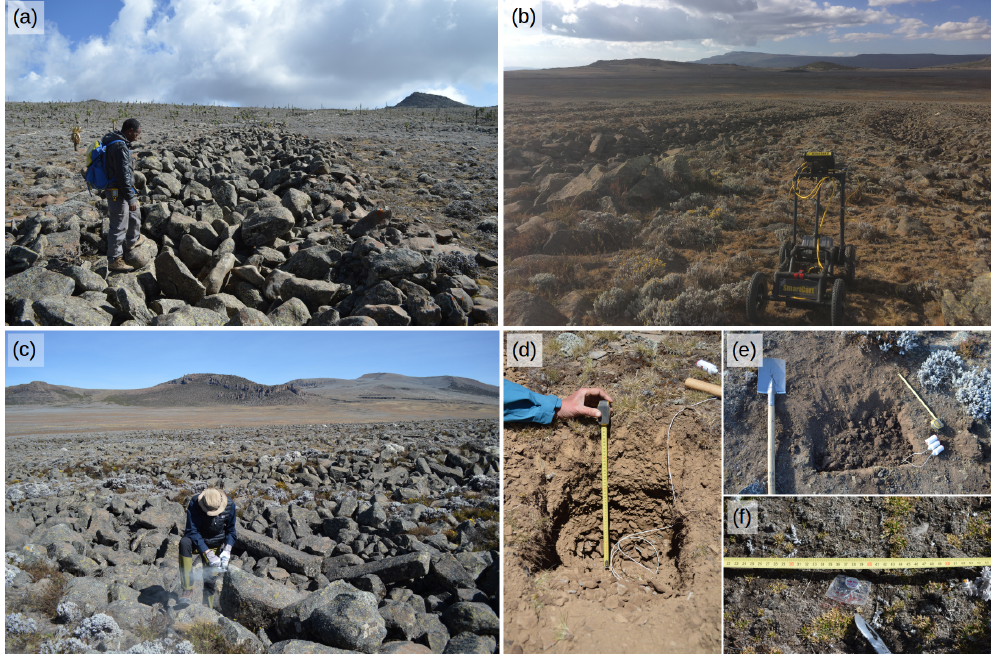
Figure 2. Field work in the Bale Mountains: (a) reconnaissance and mapping of periglacial landforms, (b) ground-penetrating radar survey, (c) sampling of stone stripes for surface exposure dating, and (d–f) installation of ground temperature loggers.